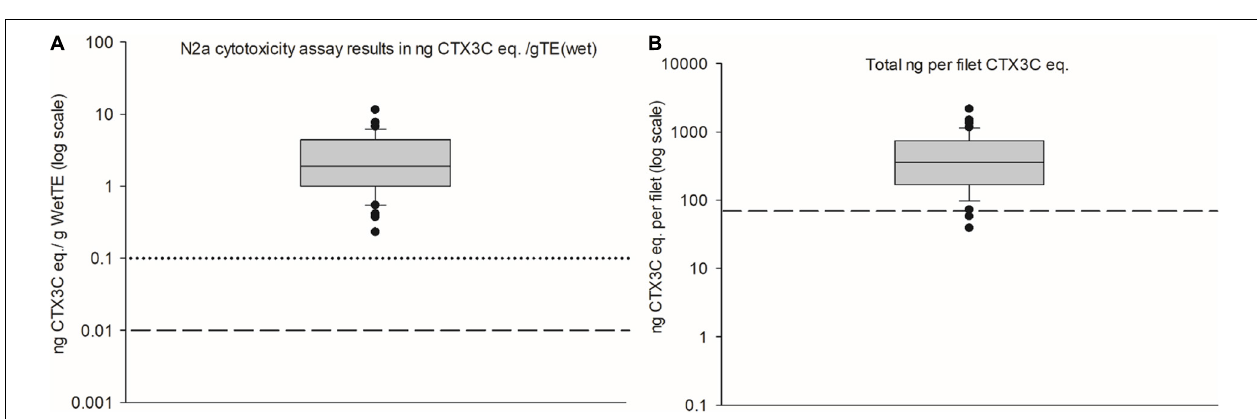
FIGURE 5 | (A) Box-and-whisker plot of the toxin concentration of CTX3C eq. per gram of fish tissue eq. for the 45 fish samples, the box represents the upper to lower quartile range, the median is marked by the horizontal line in the box, and whiskers indicate variability outside the upper and lower quartiles, outside points are outliers. Health guidance levels for CTX1B eq. (dashed line at 0.01 ppb) and C-CTX-1 eq. (dotted line at 0.1 ppb) are indicated for the context of human health seafood-consumption safety levels used by the US Food and Drug Administration. (B) Box-and-whisker plot of the total toxin content per filet (ng CTX3C eq.), with a 70 ng health guidance level (dashed horizontal line), based on the recommendation by Yasumoto regarding a total ng CTX intake for human health seafood-consumption safety (Yasumoto, 2005).